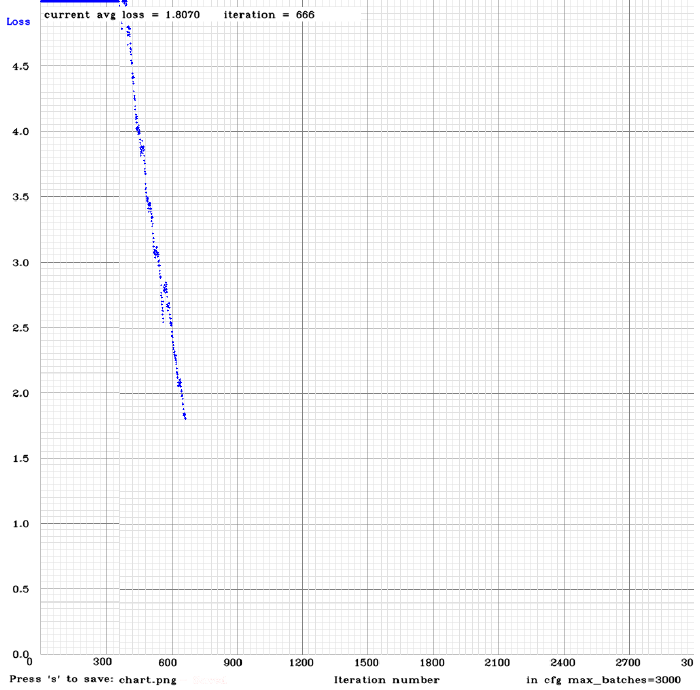
Figure 13. The average loss per number of iterations.